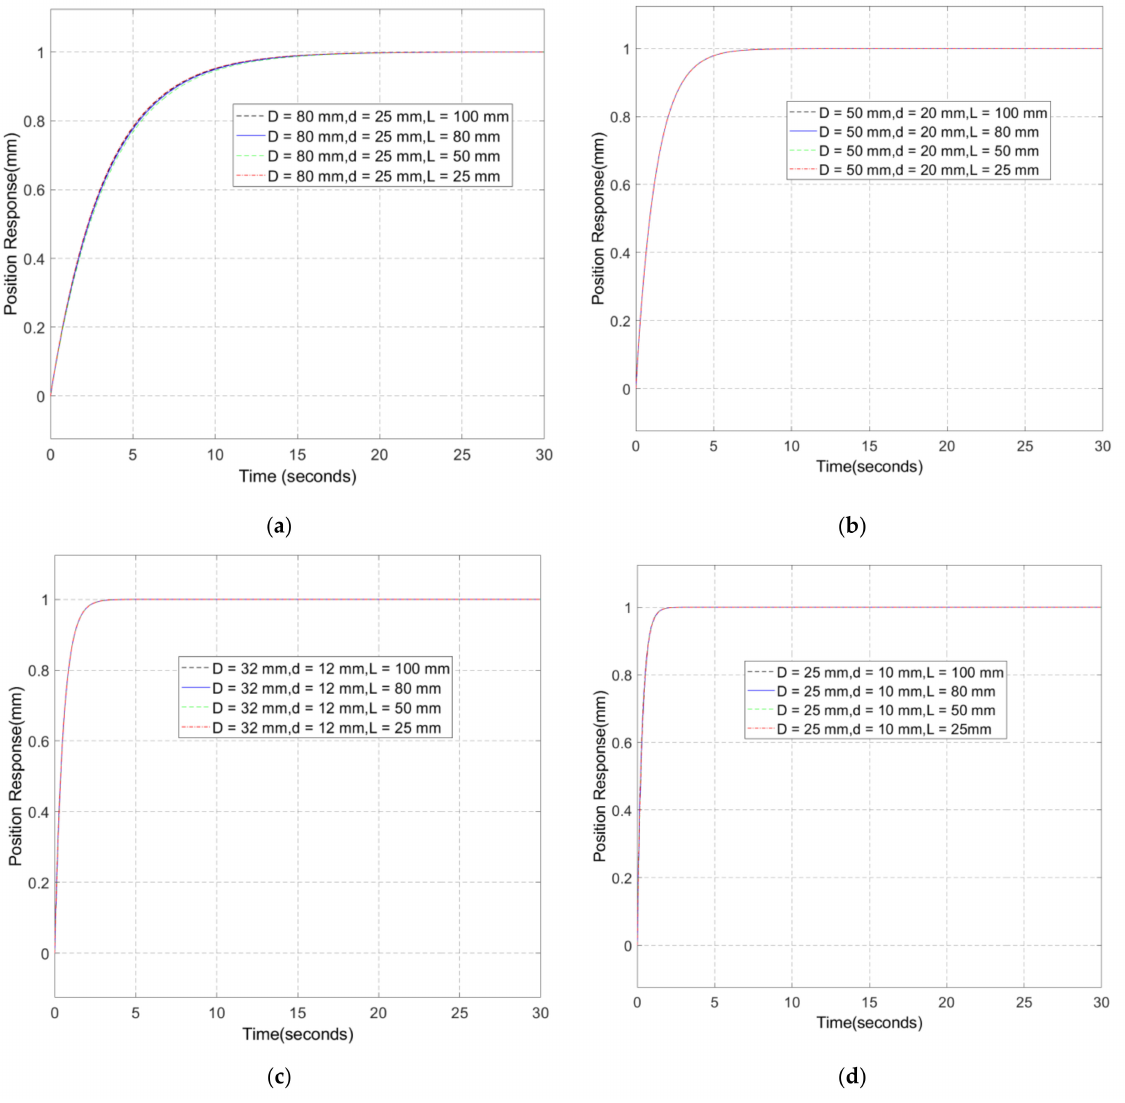
Figure 7. Response curves of different stroke positions. ( a ) D = 80 mm, d = 25 mm; ( b ) D = 50 mm, d = 20 mm; ( c ) D = 32 mm, d = 12 mm; ( d ) D = 25 mm, d = 10